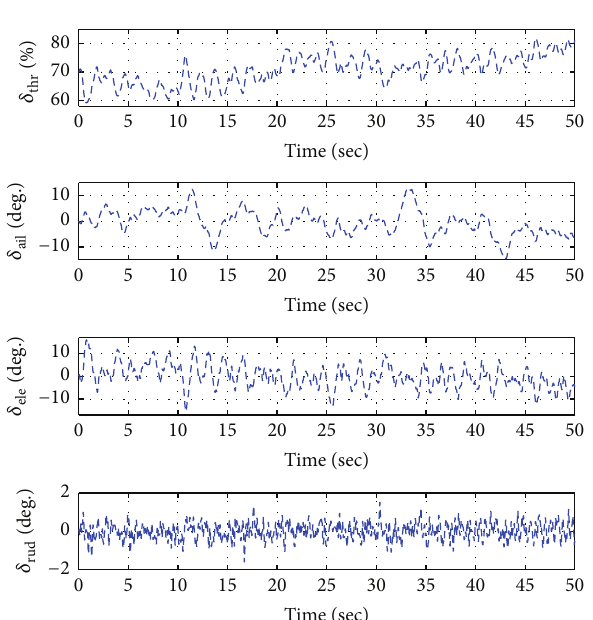
Figure 22: Time histories of position at cruise mode (Case 2). Cruise mode (15m/s).